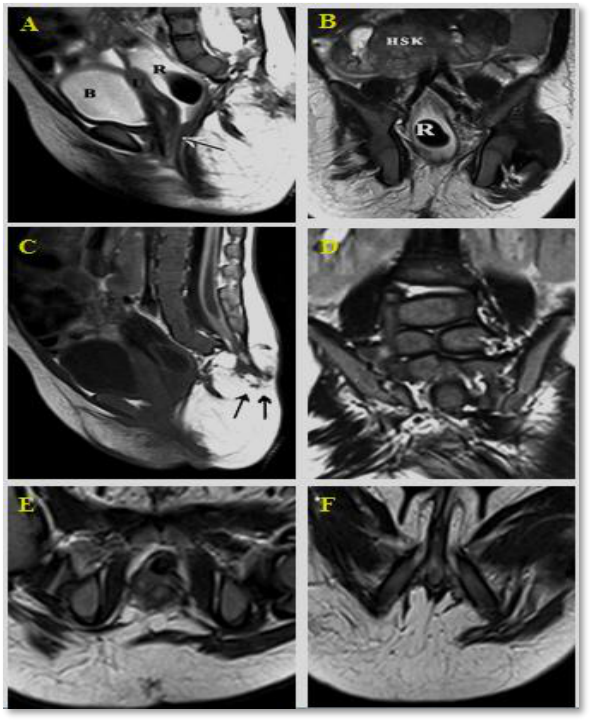
Figure 4: Intermediate ARM with rectovaginal fistula and multiple additional anomalies in 9 months old female child.